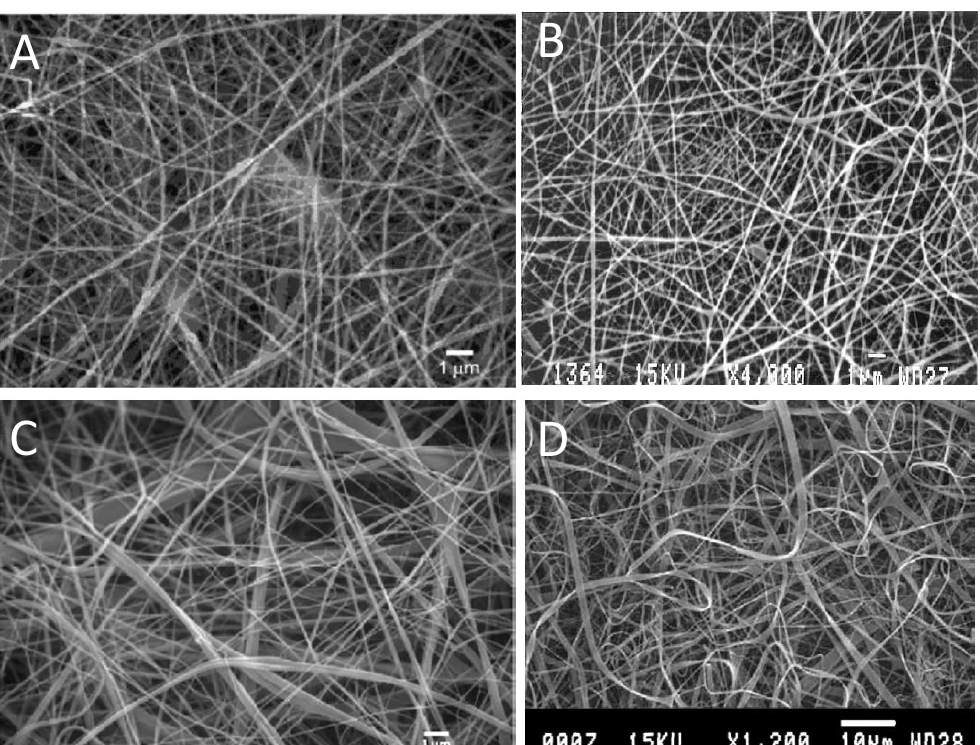
Figure 3. Scanning electron micrographs (SEM) of electrospun collagens type